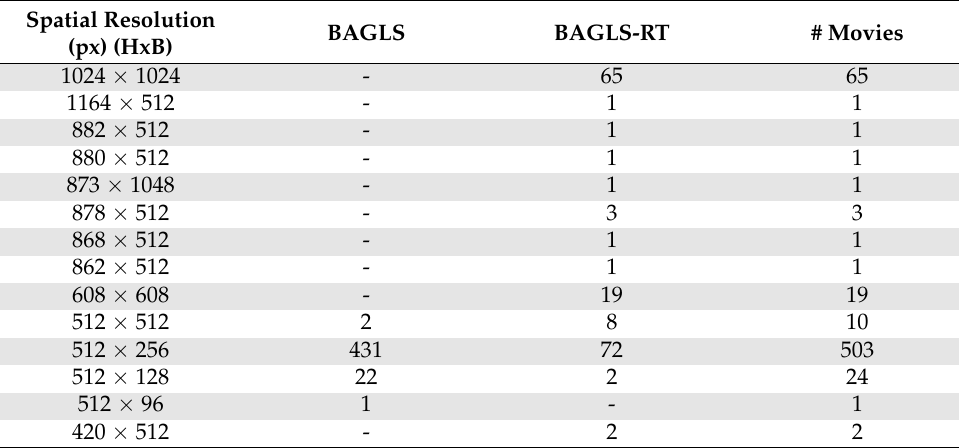
Table A4. Included spatial resolutions of HSV